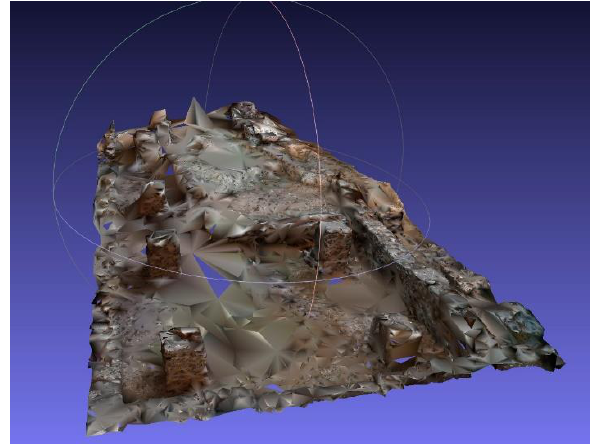
Figure 2. Model automatically reduce in Reality Capture to